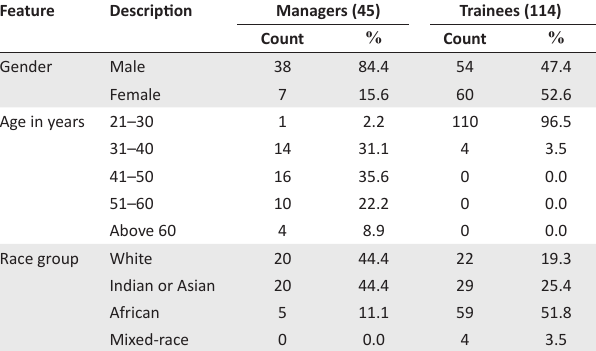
TABLE 3: Demographic profile of